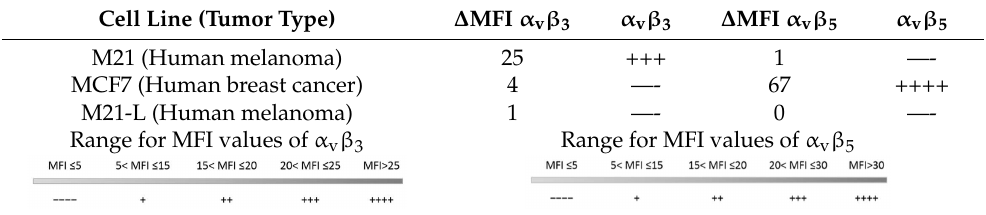
Table 2. Variation in integrins expression on the tumor cell lines used in our experiments.